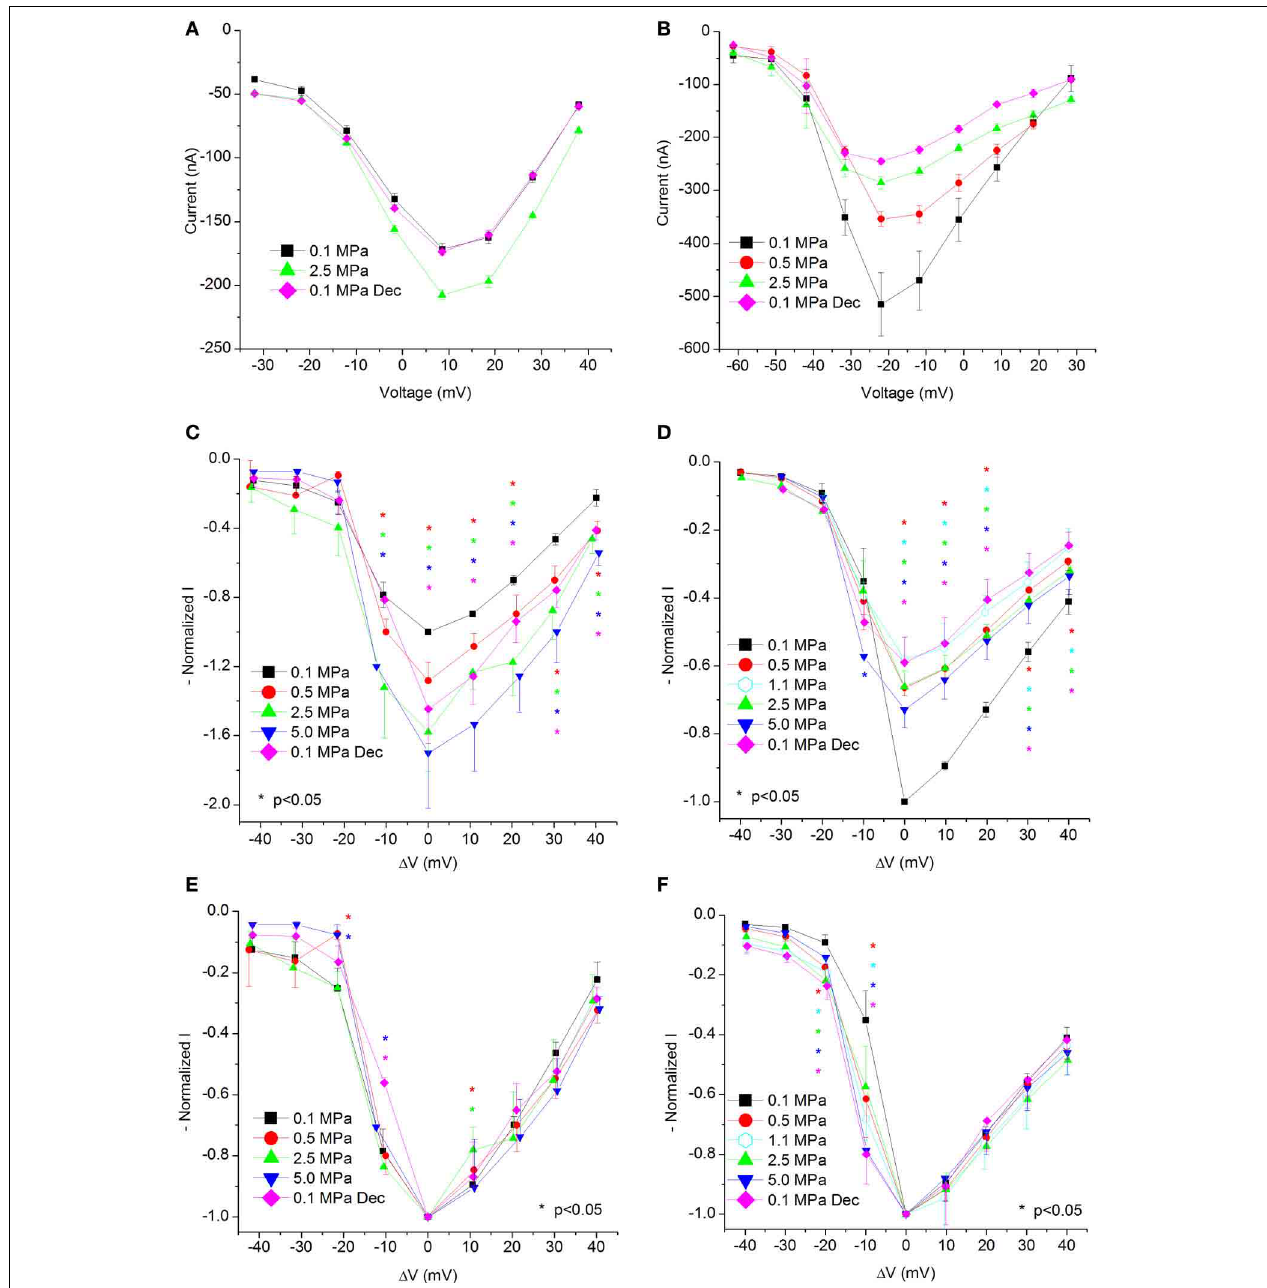
FIGURE 2 | I-V curves of maximal currents. (A,C,E) Ca V 1.2, (B,D,F) Ca V 3.2 channels. (A,B) I-V curve of a single oocyte. (C,D) Pooled data from 9 to 17 (C) and 7 to 9 (D) oocytes exposed to 0.5–5.0 MPa pressure (color indicated). Holding potential is adjusted so that 0 indicates the potential at which maximal current is obtained (V Imax ).